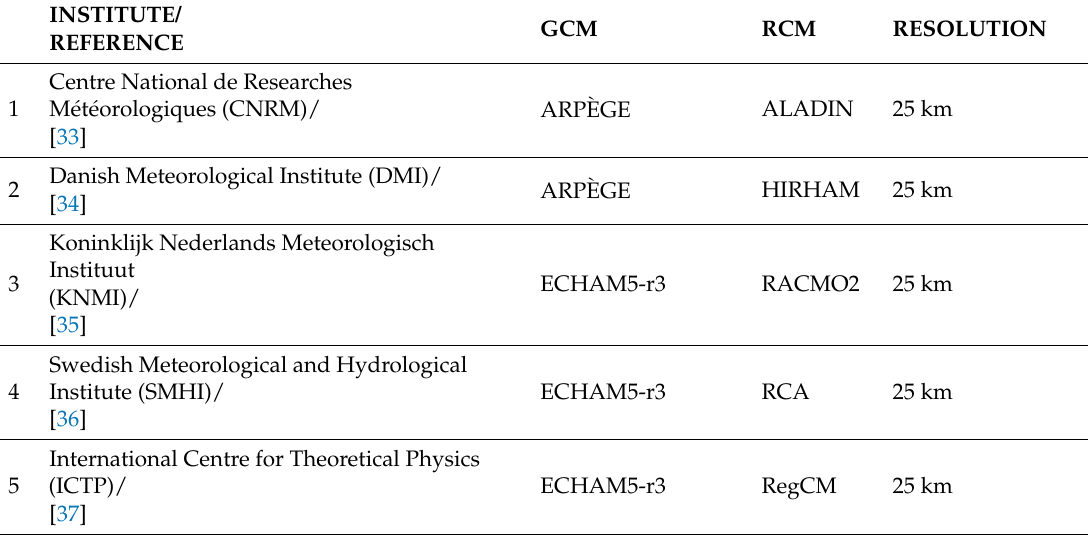
Table 2. The institute, global climate models (GCMs), regional climate models (RCMs) and resolution of chosen models from the ENSEMBLES EU